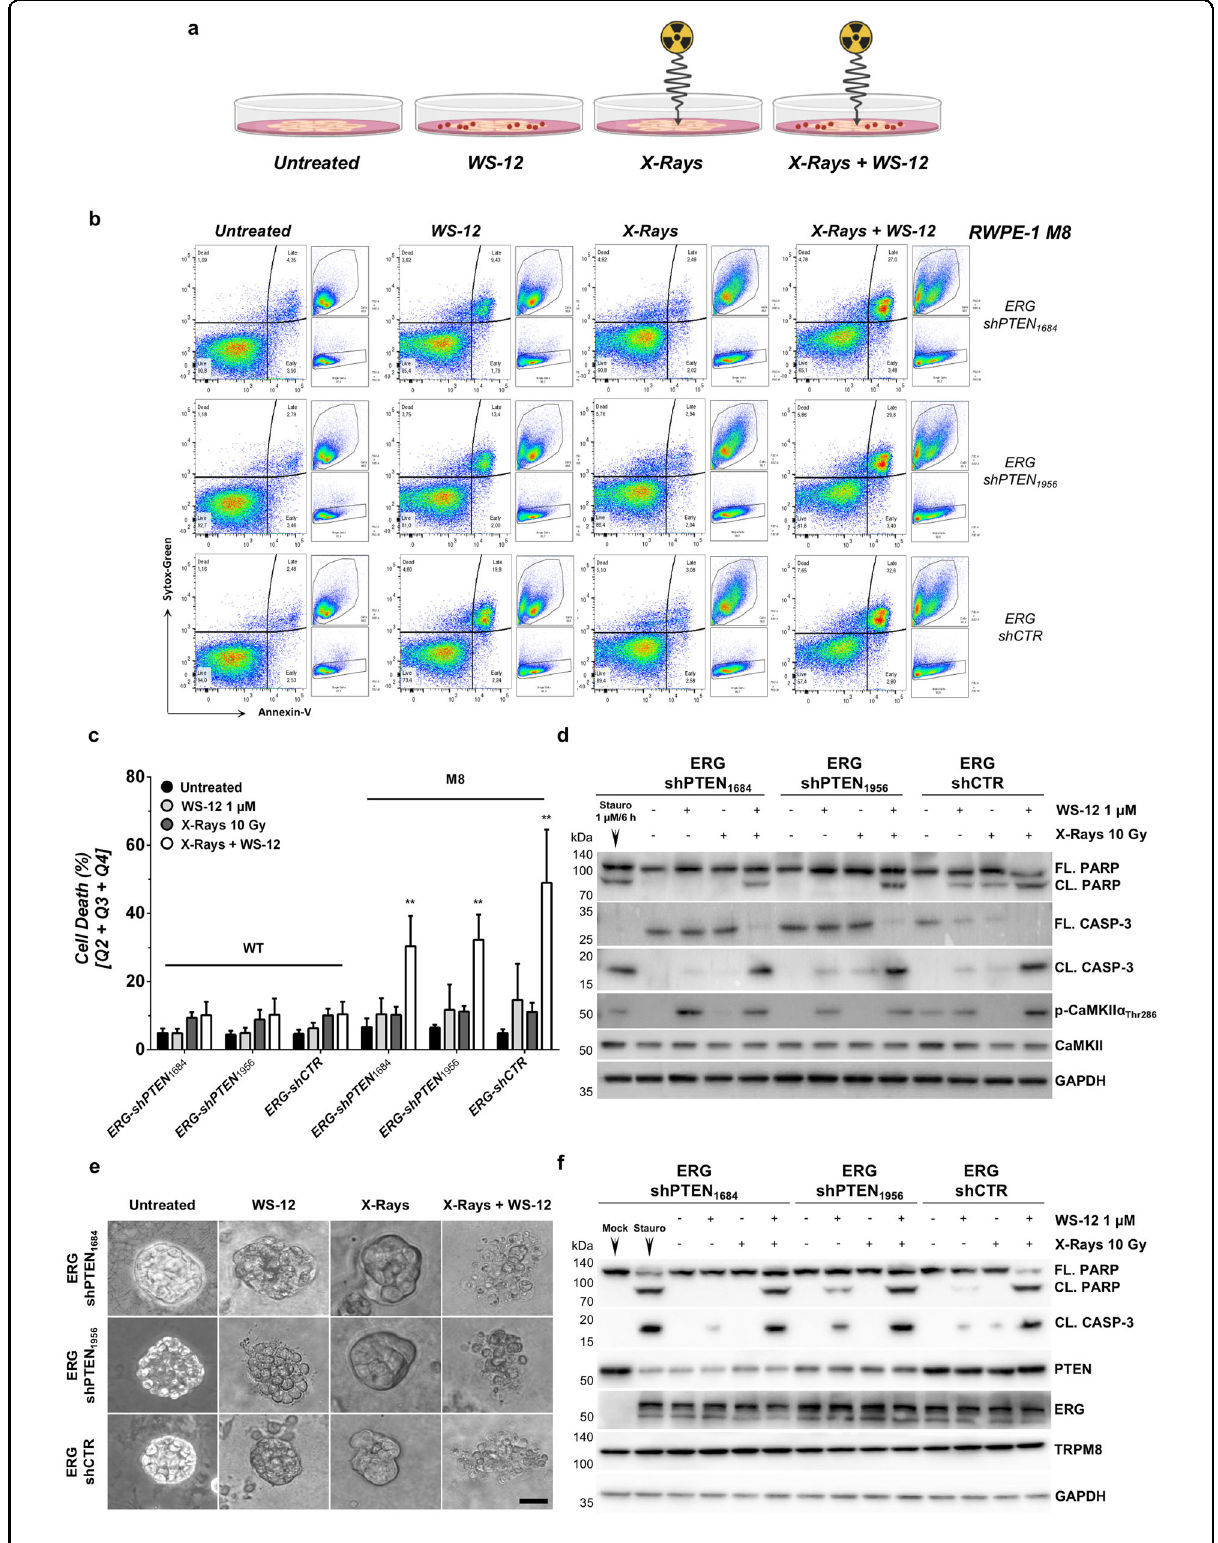
Fig. 5 (See legend on next